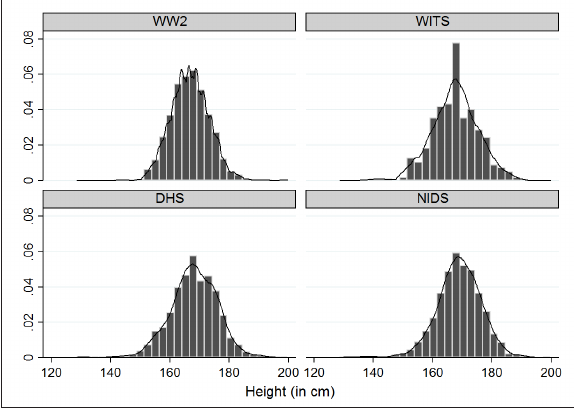
Figure 1: Histograms of heights of black men from four data sources.